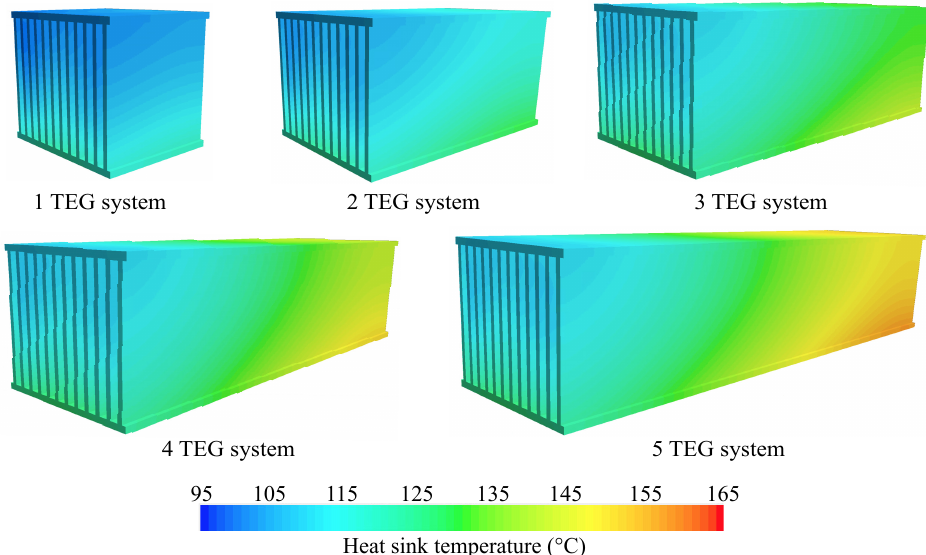
Figure 13. Temperature distribution of heat sinks at the most effective fan speed of SMF